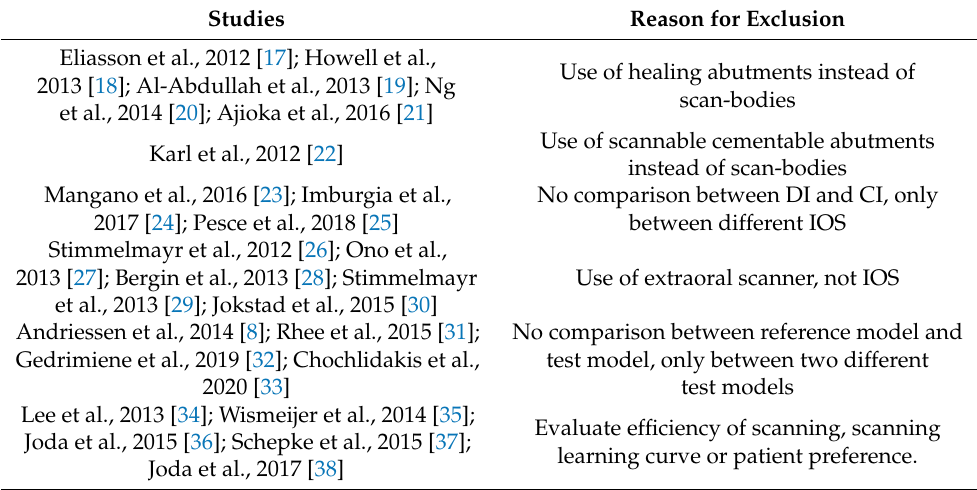
Table 2. Studies excluded after reading the full text and reasons for